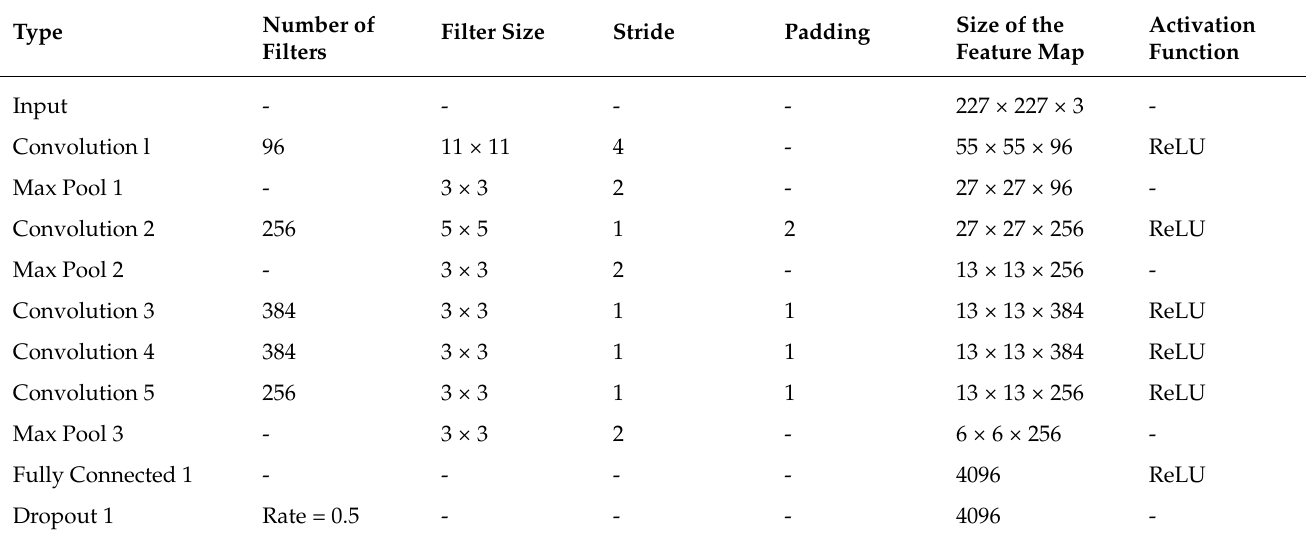
Table 2. AlexNet